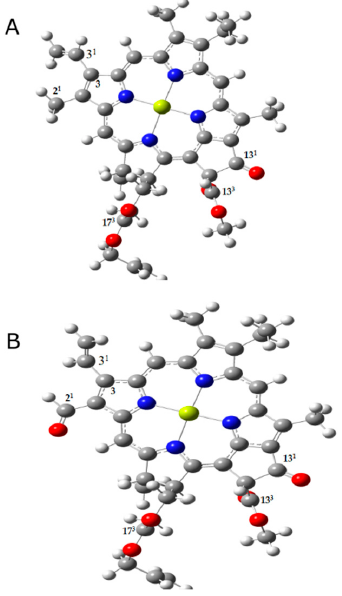
Figure 1. Structures of chlorophyll a ( A ) and chlorophyll f ( B ) models used. Chlorophyll phytyl tail is replaced by CH 2 CH=CH 2 . The carbons associated with carbonyl modes of interest are numbered in the figure according to the IUPAC numbering